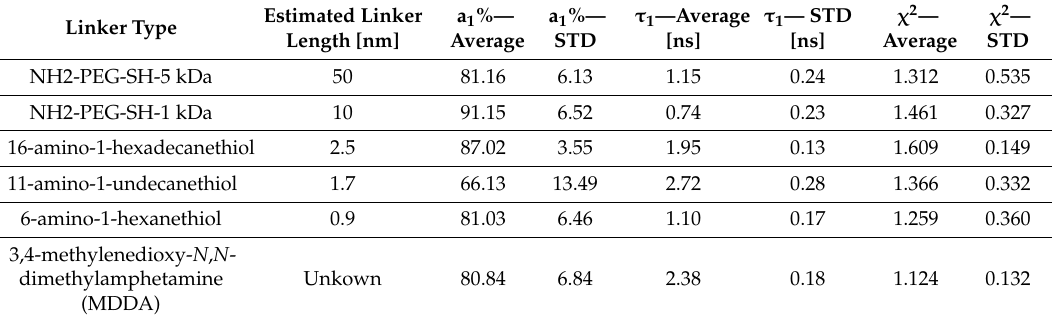
Table 1. This table summarizes the results of τ 1 , a 1 % (the percentage of τ 1 of the pixel’s FLT), χ 2 (the fit quality parameter) average, and the standard deviation (STD) values for fluorescein-conjugated GNRs with different linkers.